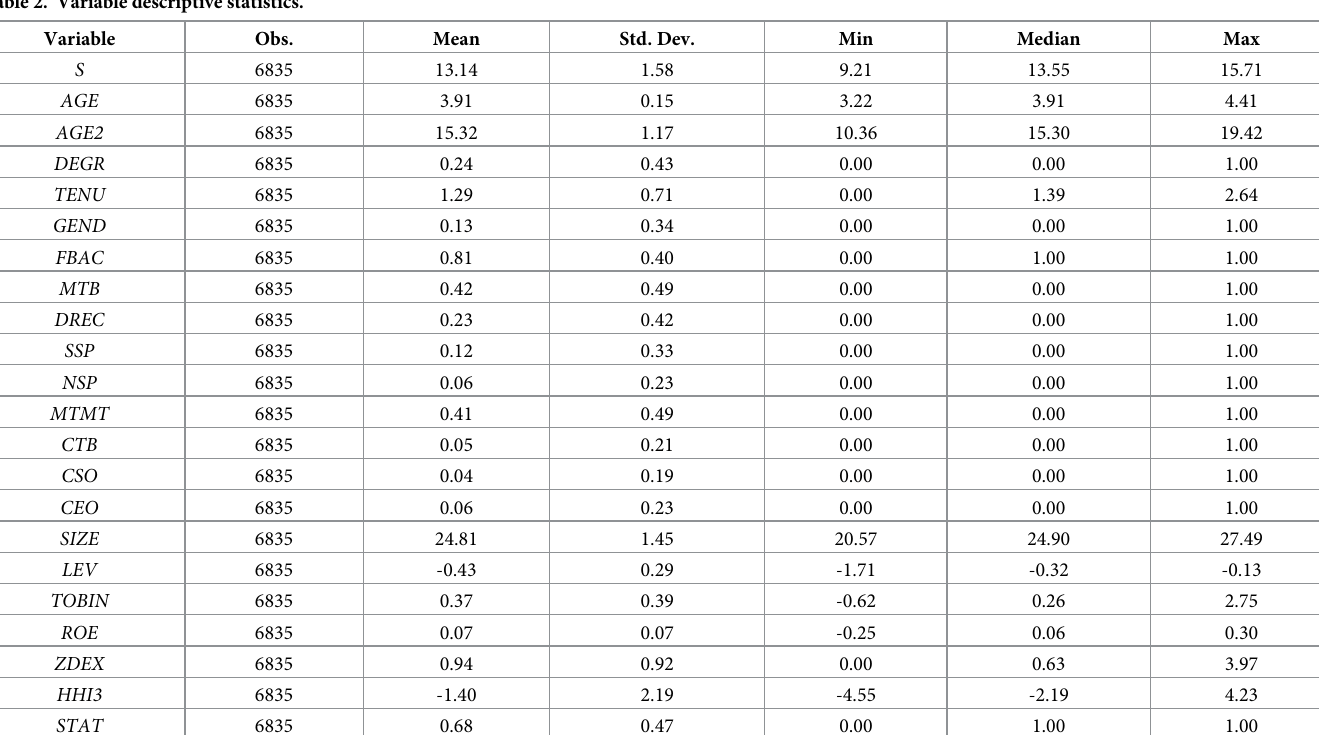
Table 2. Variable descriptive